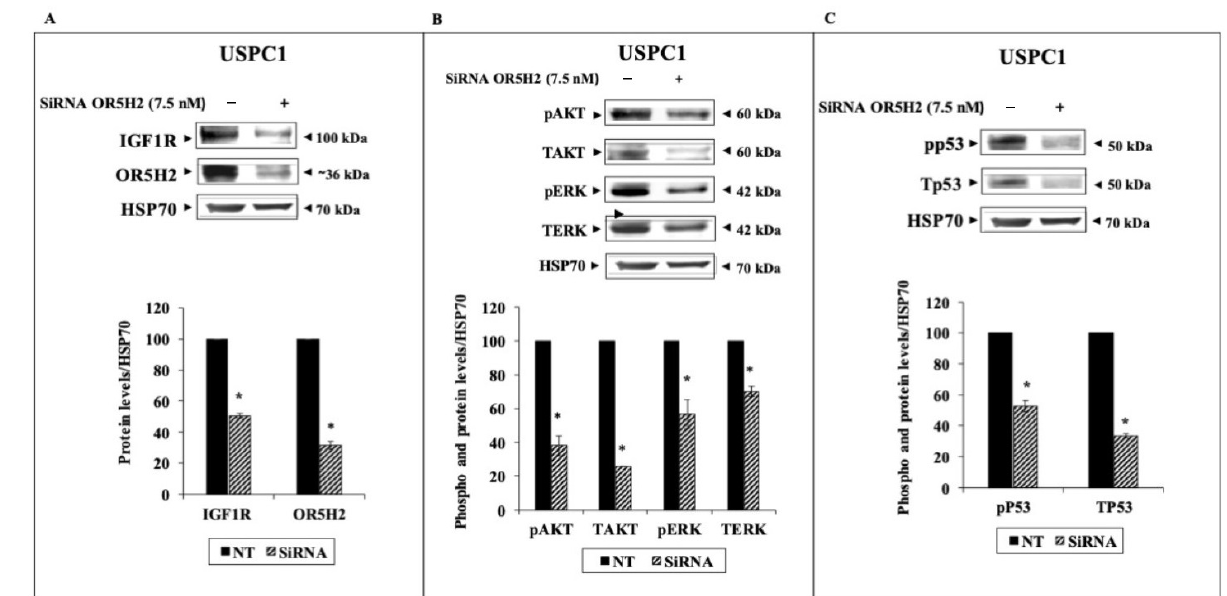
Figure 4. Effect of OR5H2 knockdown on downstream signaling proteins in USPC1 cells. USPC1 cells were transfected with 7.5 nM of OR5H2 siRNA (or non-targeting siRNA) for 72 h. At the end of the incubation period cells were harvested and lysates (130 mg) were analyzed by Western blots for IGF1R ( A ), total and phospho-AKT and ERK ( B ), and total and phospho-p53 ( C ) levels. Scanning densitometric analyses are presented for each protein. *, p < 0.01 versus respective